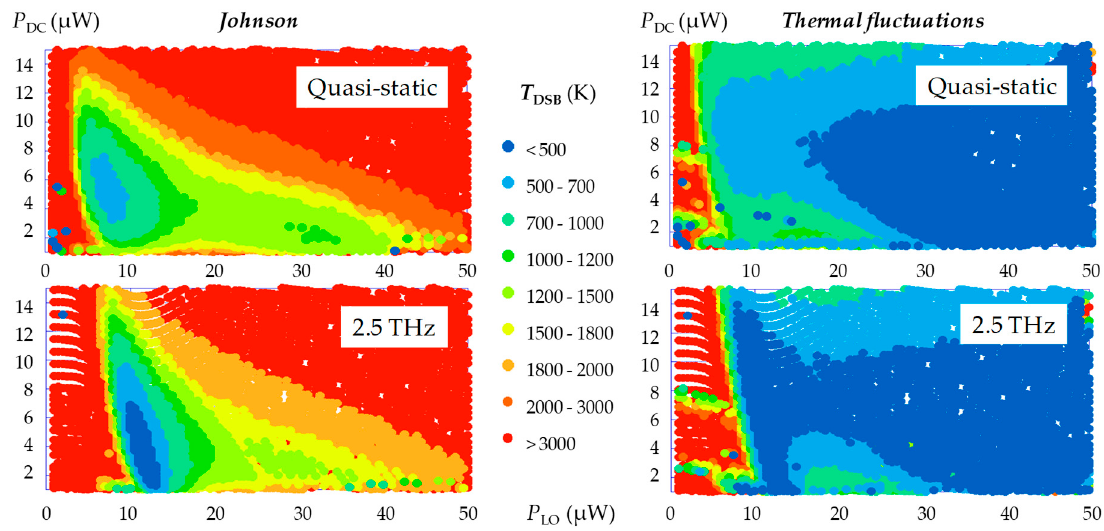
Figure 8. For an HEB constriction of dimensions L = w = 400 nm and θ = 35 nm (Figure 1), maps exhibiting Johnson noise and thermal fluctuation noise contributions to T DSB levels in DC bias power vs. LO power coordinates. Impedance matching coefficient α imp with the antenna was included.